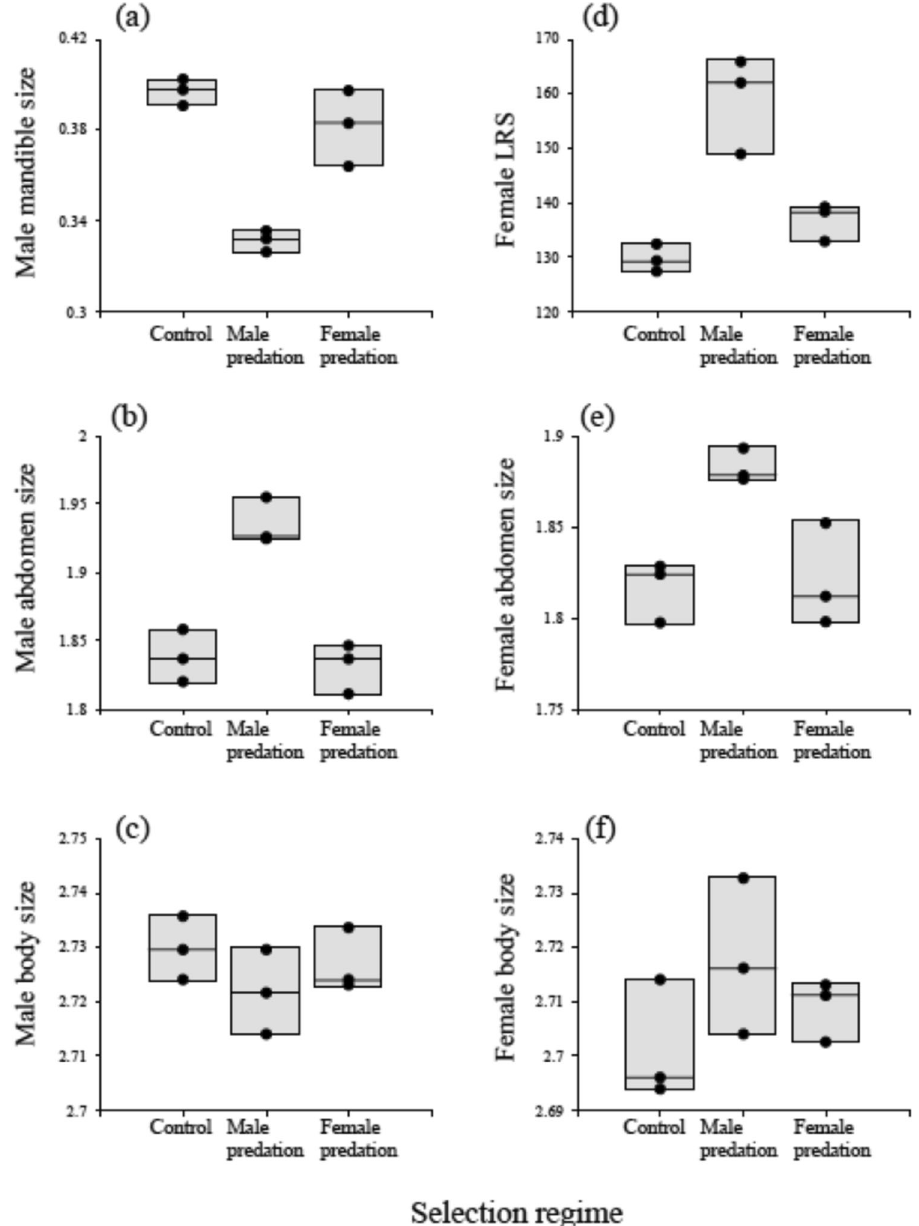
Fig. 2 Trait values after eight generations of experimental evolution. Replicate populations (3/treatment) were exposed to either male-only predation (middle columns), female-only predation (right-hand columns) or no predation (controls: left-hand columns), and effects on a range of traits was assessed. Traits were: Male mandible size (mm) ( a ), Male abdomen size (mg) ( b ), Male body size (mg) ( c ), Female lifetime reproductive success (LRS: offspring number) ( d ), Female abdomen size (mg) ( e ), and Female body size (mg) ( f ) (shown are upper and lower quartile (the box) with medians (lines) and each dot represents the mean of one replicate population). Only populations evolve and thus population is the biologically relevant unit of replication in an experimental evolution study. Mean population values were estimated by measuring 20 individual males and female beetles/population. Source data are provided as a Source Data fi